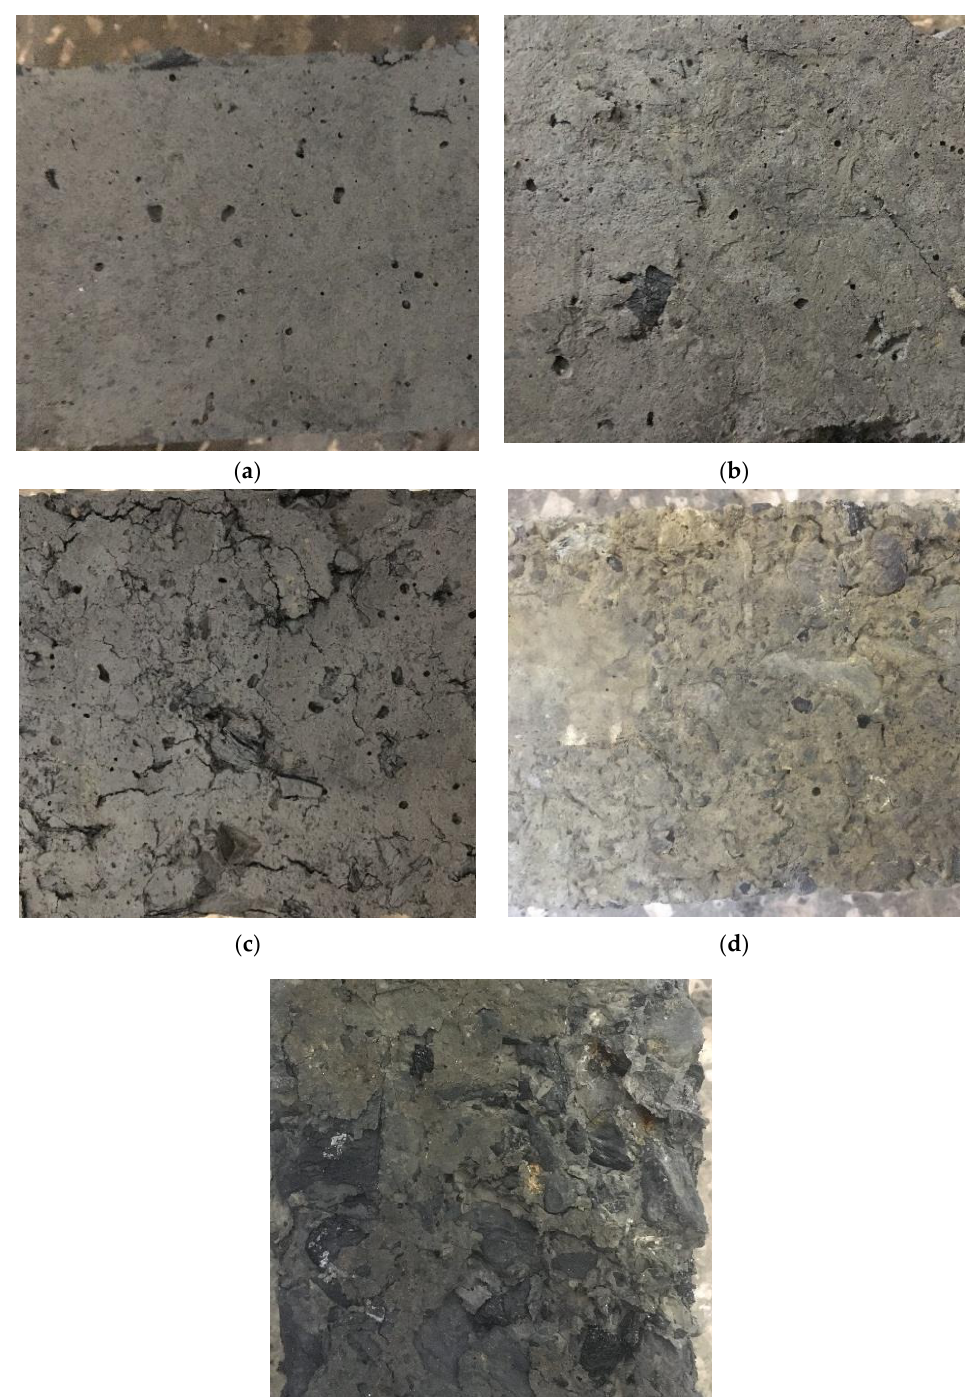
Figure 5. Surface pattern of I-78 specimens after immersed in different days. ( a ) Immersed for 28 days; ( b ) Immersed for 56 days; ( c ) Immersed for 84 days; ( d ) Immersed for 112 days; ( e ) Immersed for 140 days.